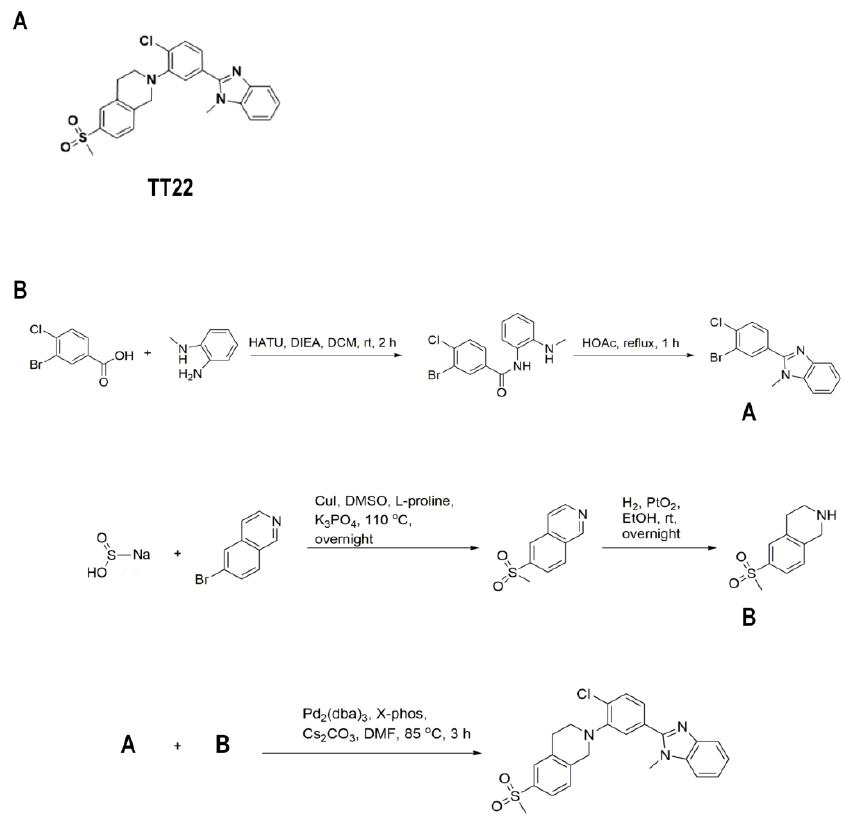
Figure 4. The structure and synthetic route of compound TT22. ( A ) Structure of compound TT22. ( B ) Synthetic route of compound TT22.